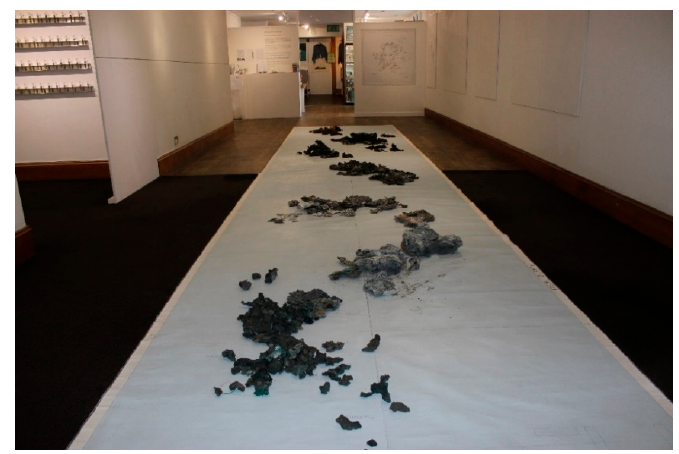
Figure 5. Archipelago . Exhibition overview. Photograph created by the author.